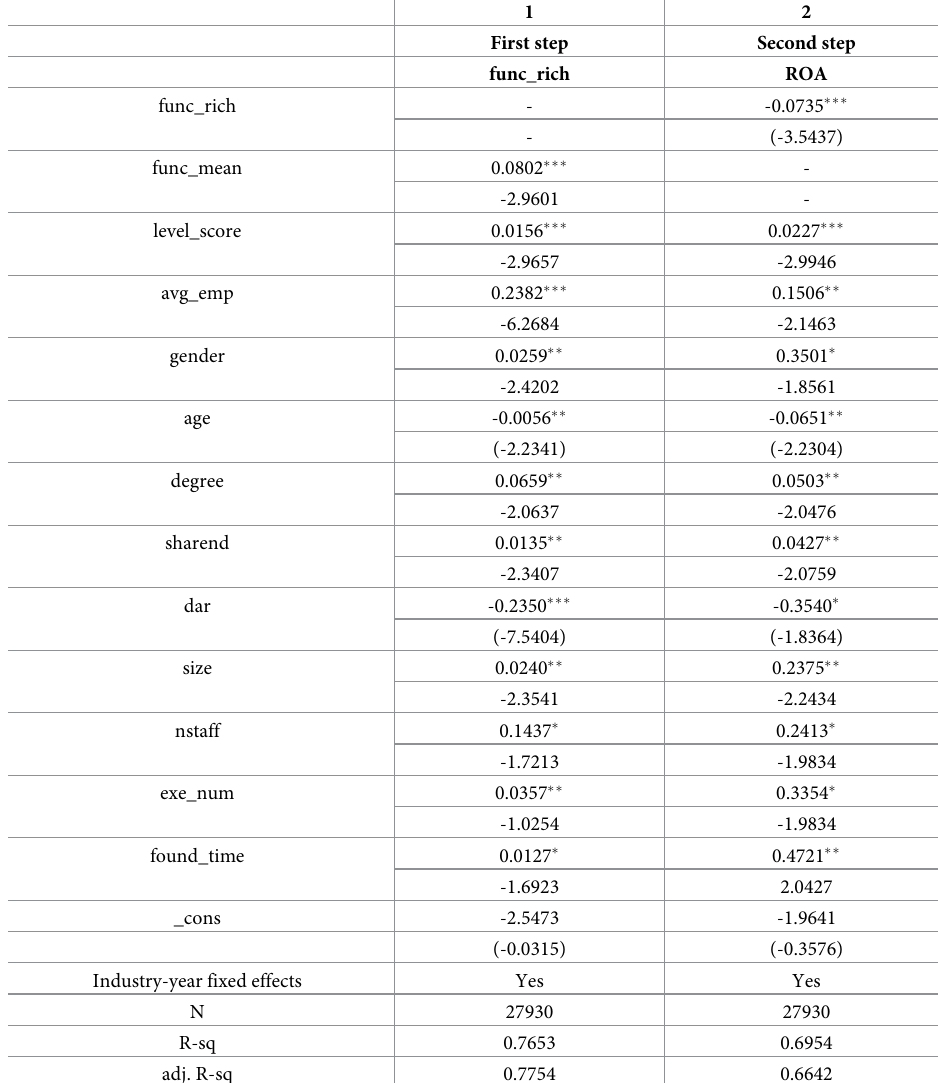
Table 5. Regression results of instrumental